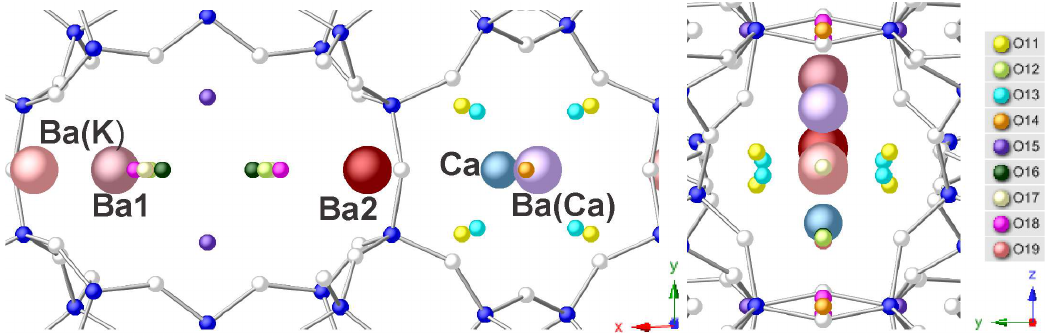
Figure 5. Structure representation of Ba-clinoptilolite (90 °C, 22 d). Left—channel A, middle—channel B, right—channel C.